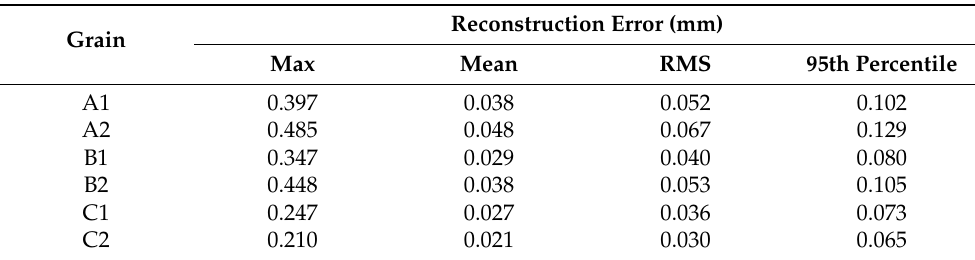
Error of the surface measurement (Hausdorff distance from the photogrammetry- reconstructed surface to the CT model surface).